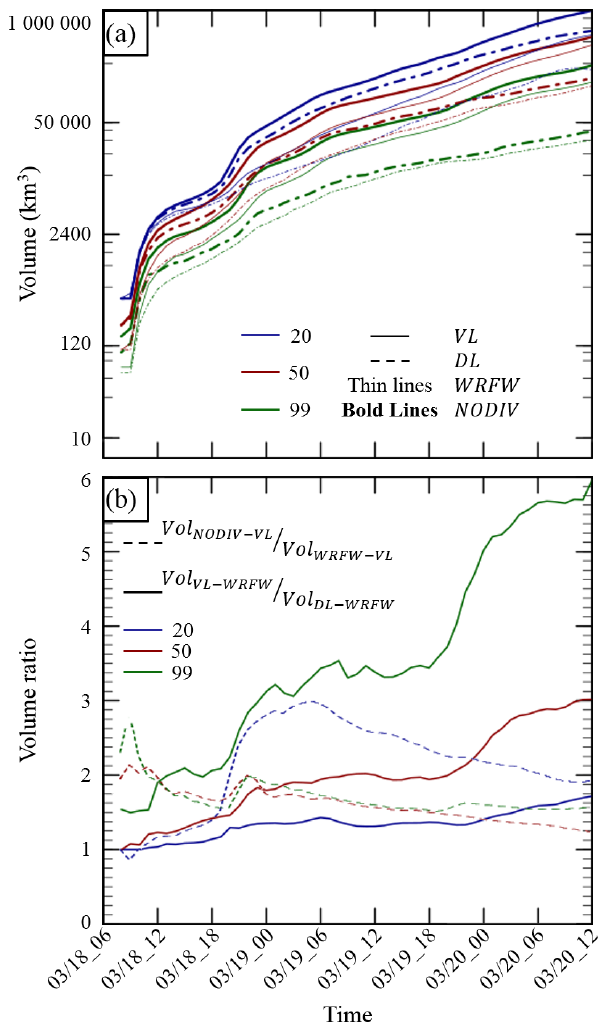
Figure 8. (a) Minimum volume evolution calculated for 50% of the SO 2 total mass in the atmosphere. (b) Volume ratio evolution by